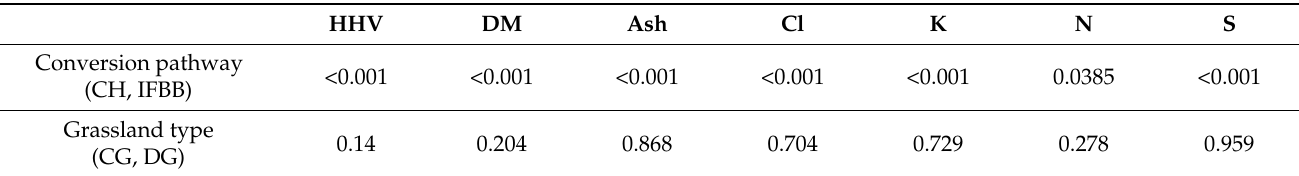
Table 5. Results of analysis of variance ( p -values) for the effect of conversion pathway (combustion of hay (CH) and integrated generation of solid fuel and biogas from biomass (IFBB)) and for the effect of grassland type (clover-grass (CG) and diverse mixture (DG)) on higher heating value (HHV), dry matter (DM), ash and mineral concentration in the hay and IFBB press